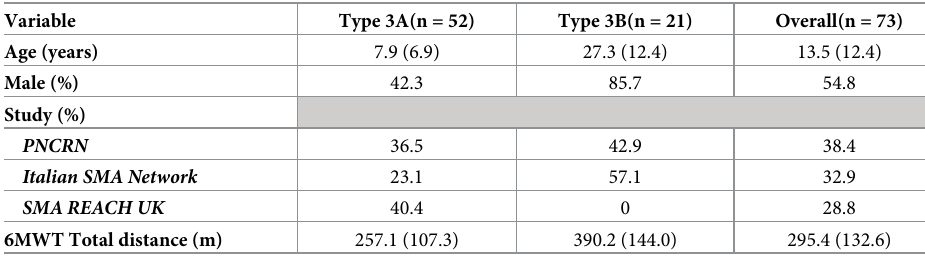
Values are mean (standard deviation) or % as indicated PNCRN = Pediatric Neuromuscular Clinical Research Network 6MWT = Six-Minute Walk Test male participants walked a longer distance on average (325 ± 137 m) than female participants (259 ± 121 m) (difference = 66 m, 95% CI 5–126, p = 0.03). Total distance walked was weakly associated with age (r = 0.25, p = 0.04). The mean rates of change in 6MWT distance, overall and by SMA subtype and age group, are provided in Table 2. The overall mean rate of change was -7.8 m/year (p = 0.009) and this did not differ by SMA subtype (type 3A: -8.5 m/year; type 3B: -6.6 m/year; p = 0.78) or gender (male: -10.0 m/year; female: -5.9 m/year; p = 0.51), but it did differ by age group ( < 6: 9.8 m/ year; 6–10: -7.9 m/year; 11–19: -20.8 m/year; (cid:21) 20: -9.7 m/year; p = 0.005 for the interaction